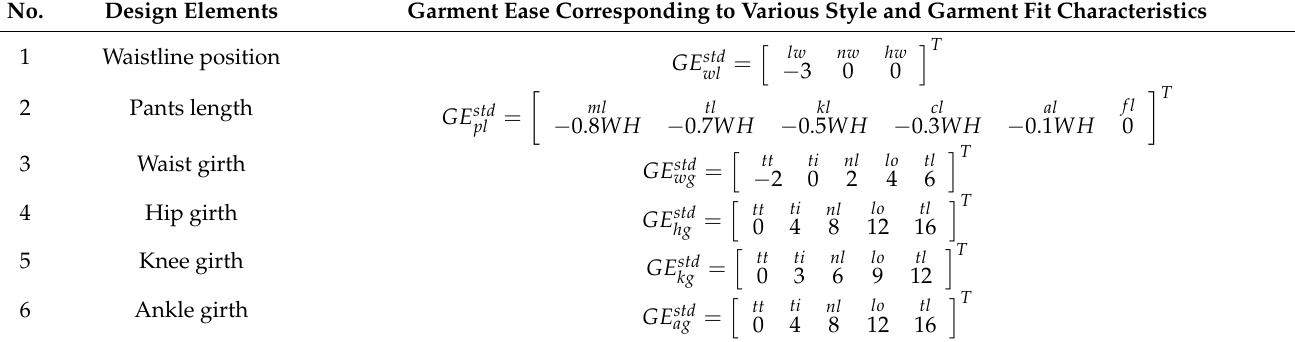
Table 8. The garment ease in the garment ease allowance database (Unit: cm).